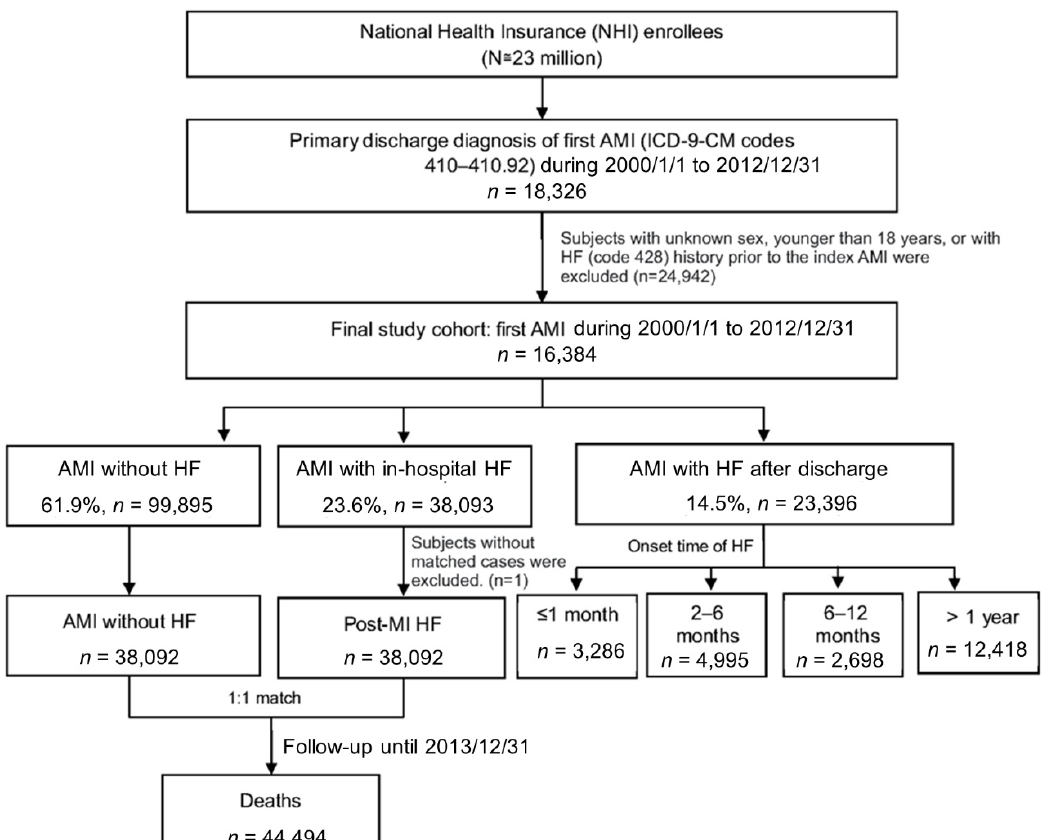
Figure 1. Study flow chart and the summary of the distribution of post-AMI cases in this study cohort.